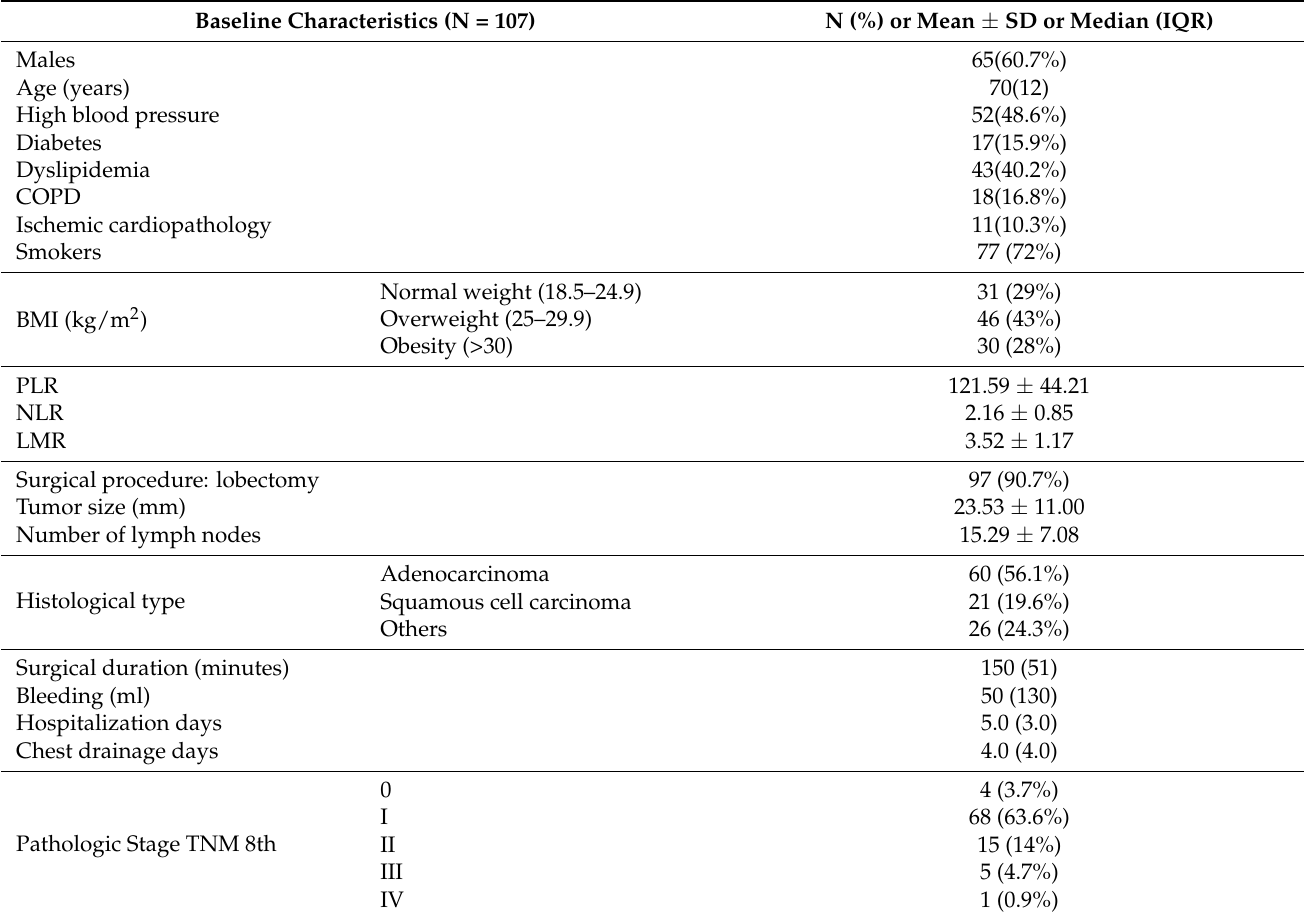
Table 1. Clinical, pathological, surgical, nutritional, and systemic inflammatory parameters of the study